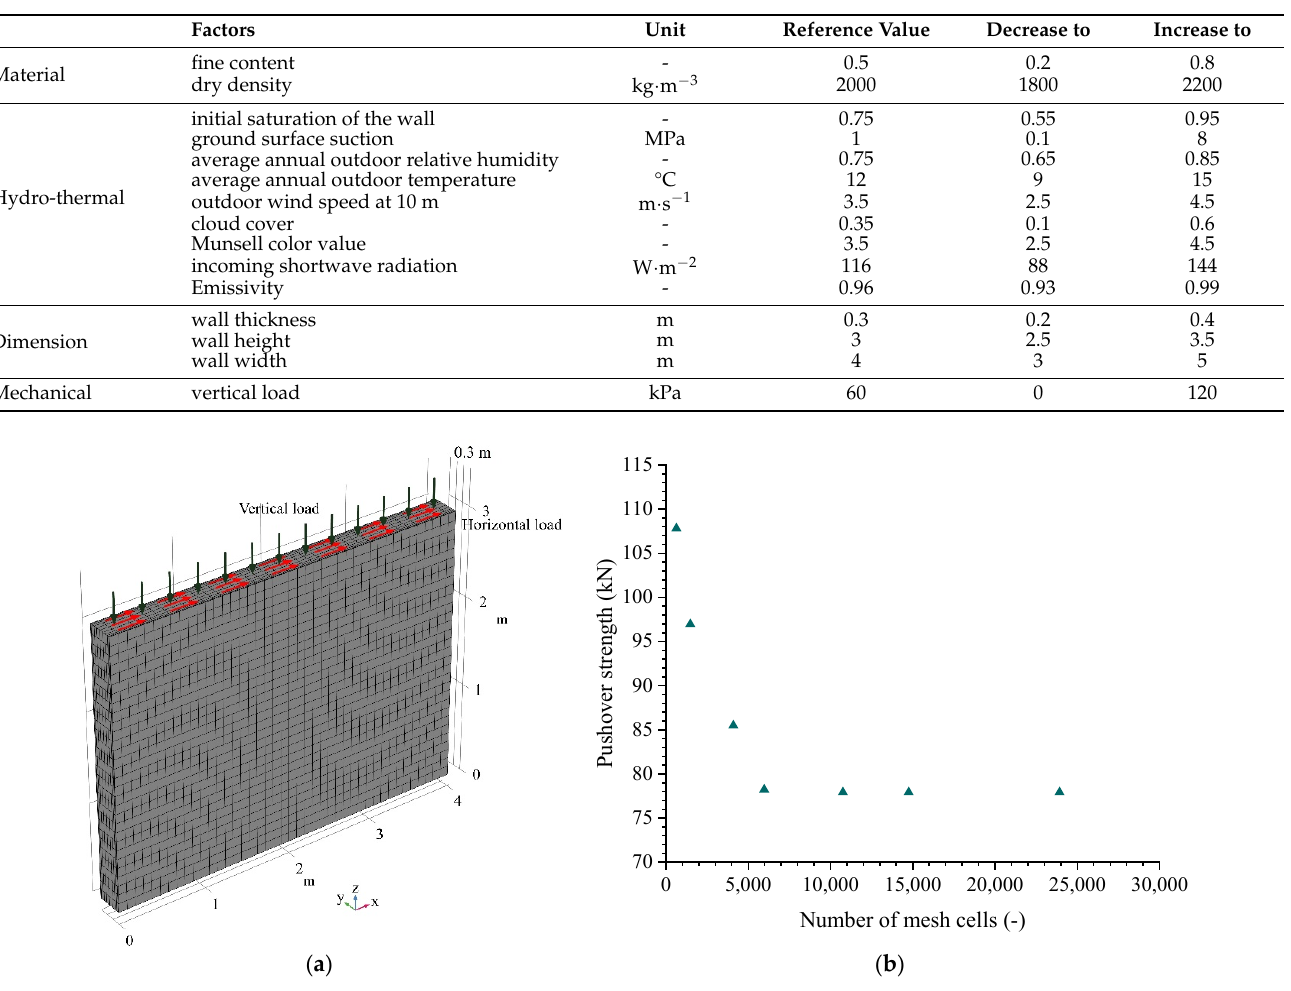
Table 1. Factors studied in this work with their reference values and the range of variation of each factor.